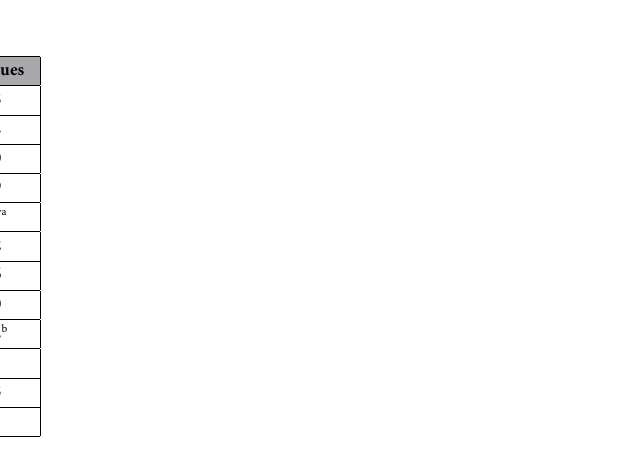
Table 3. Tongue colors and result of the statistic test. The numbers 1–4 correspond to the areas defined in Fig. 2. a,b There is a statistically significant difference in the a* values of area 2 ( p < 0.05) and the b* values of area 3 ( p <